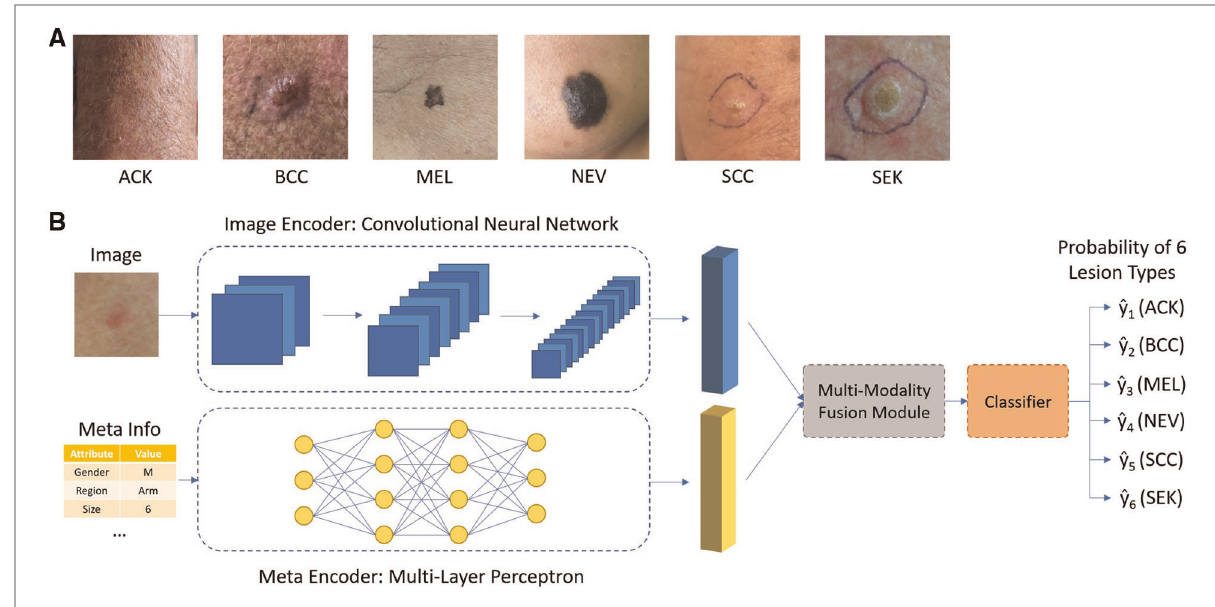
FIGURE 1 ( A ) Typical images of different types of skin lesions; ( B ) overall network architecture of the proposed